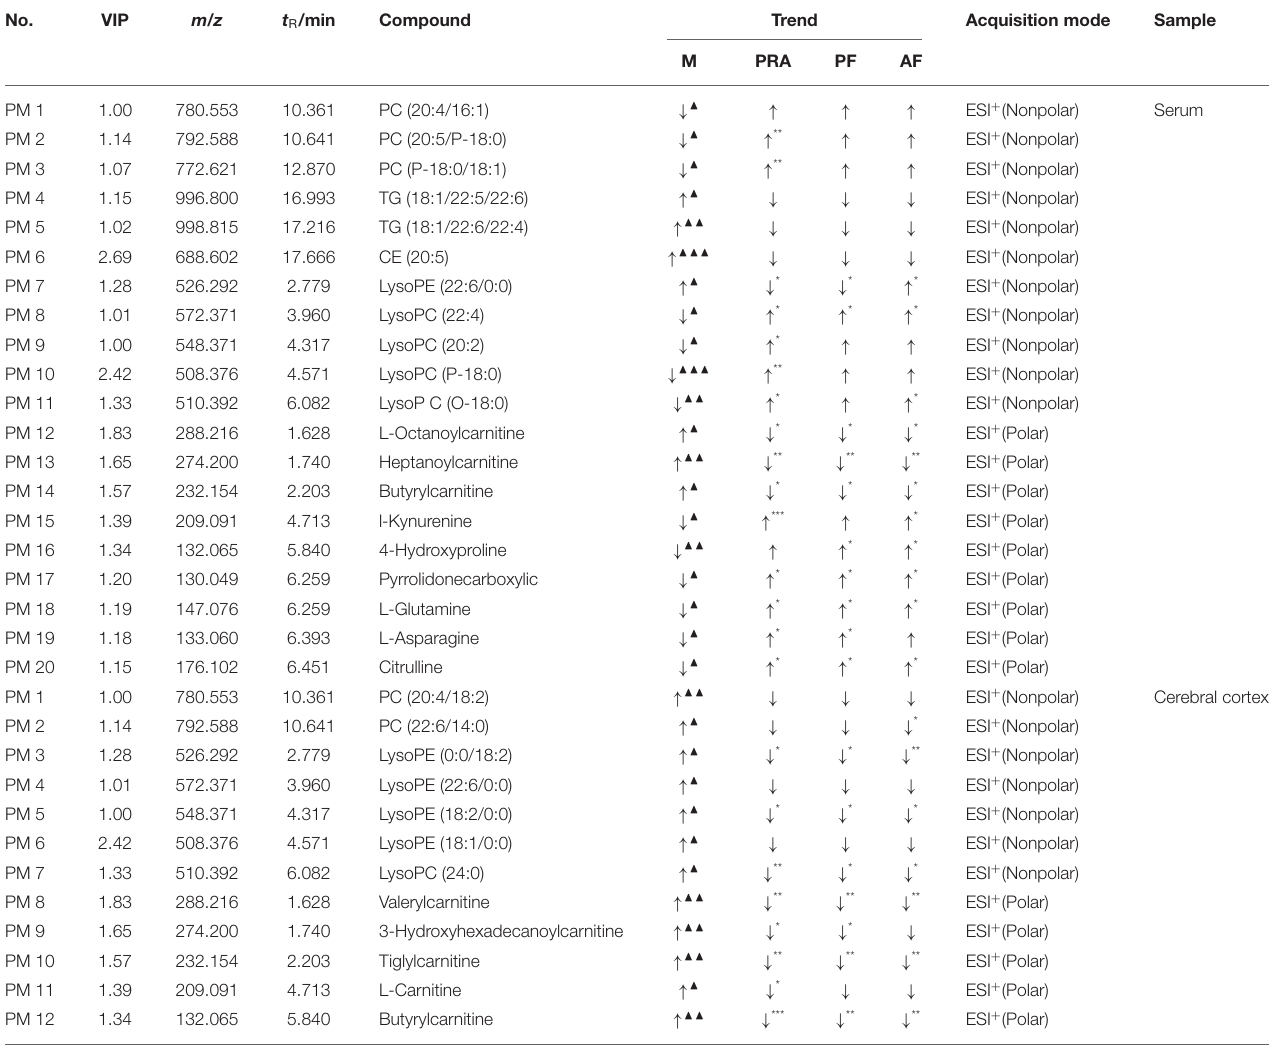
TABLE 3 | Potential biomarkers in the serum and cerebral cortex in the model rats. No. VIP m / z t R /min Compound Trend Acquisition mode